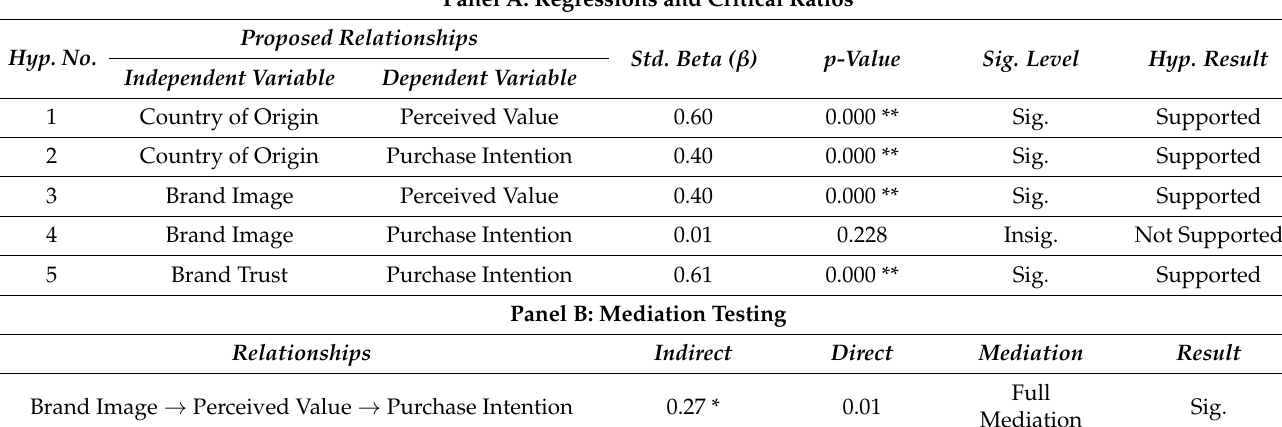
Figure 2. SEM Results. Table 3. Results and Hypotheses Summary. Panel A: Regressions and Critical Ratios